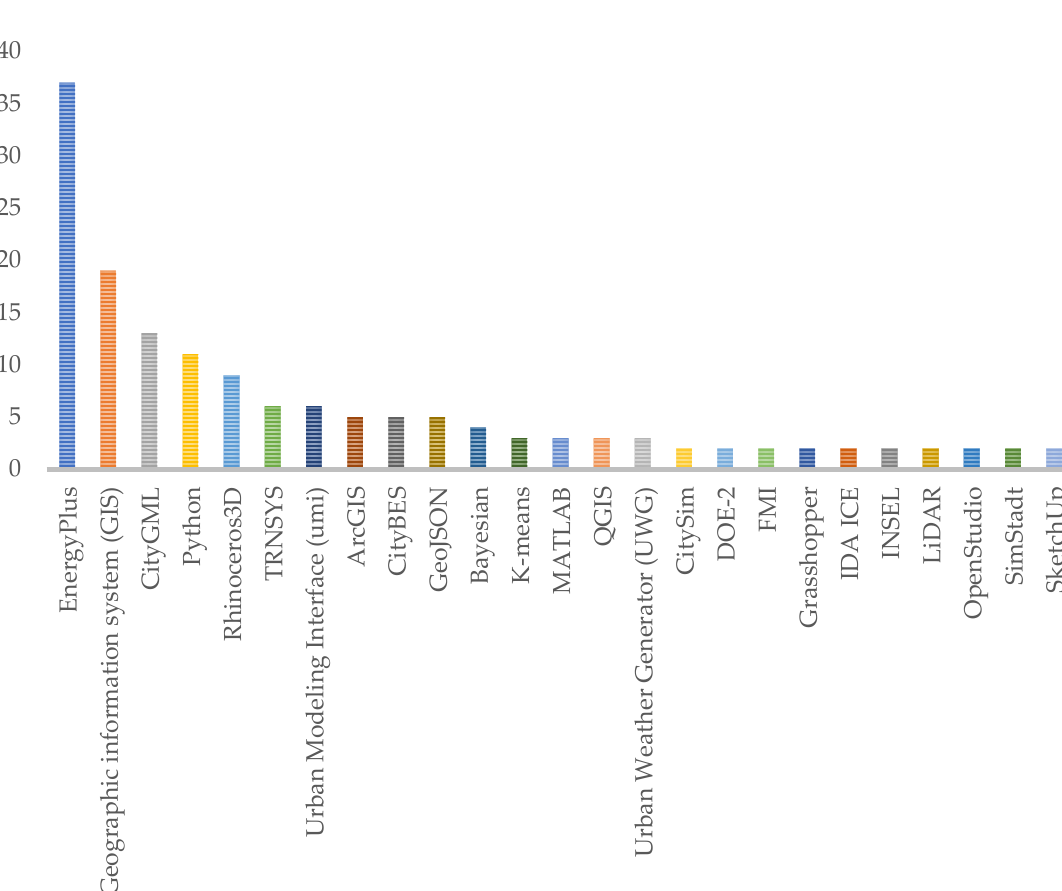
Figure 15. Use frequency of tools and file schemas in physics-based urban building energy modeling projects with at least two use cases.